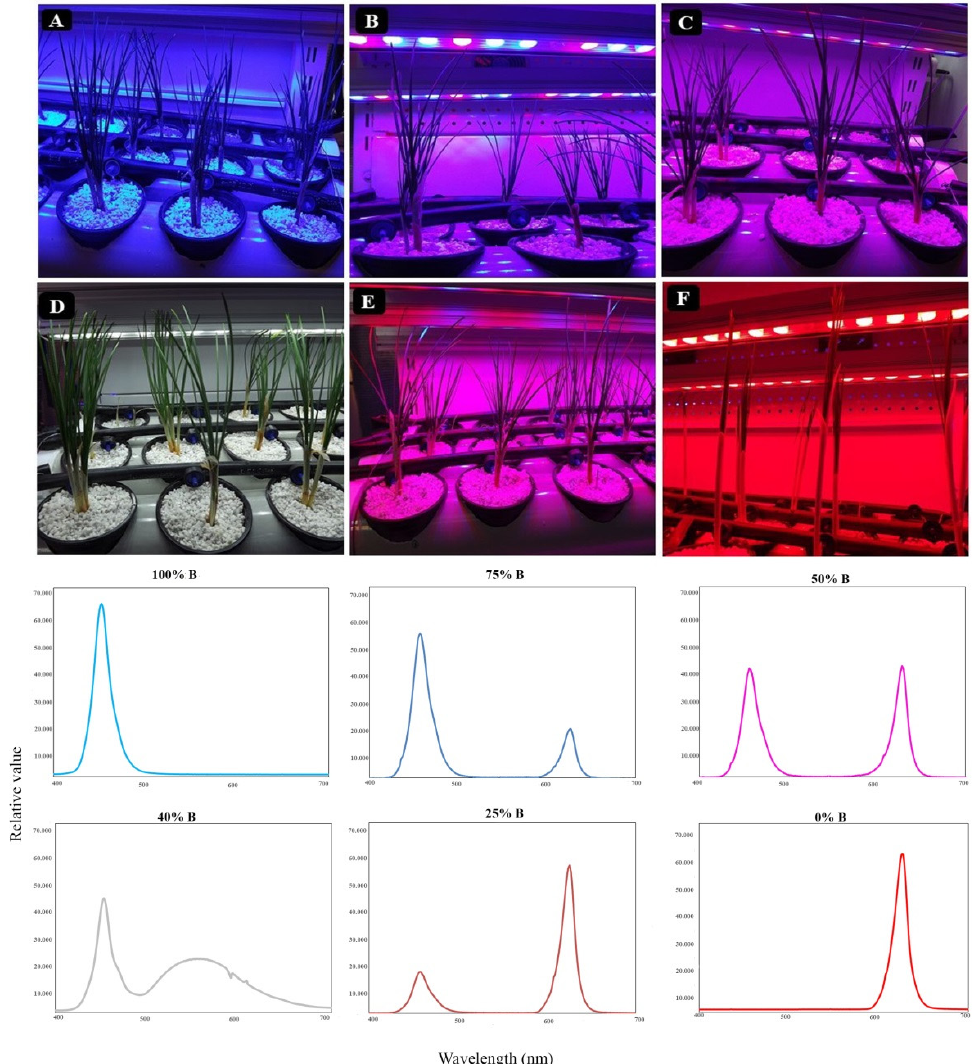
Figure 1. Growth lighting condition of saffron plants as well as spectral distribution of each lighting treatments. Six ing treatments. Six lighting treatments are shown based on percentage of blue light: 100% B ( A lighting treatments are shown based on percentage of blue light: 100% B ( A ; monochromatic blue), 75% B ( B ; 75% blue, 25% red), 50% B ( C ; 50% B, 50% R), 40% B ( D ; consisted of 40% in the range of blue and 20% in the range of red), 25% B ( E ; 25% B, 75% R), 0% B ( F ; monochromatic red).